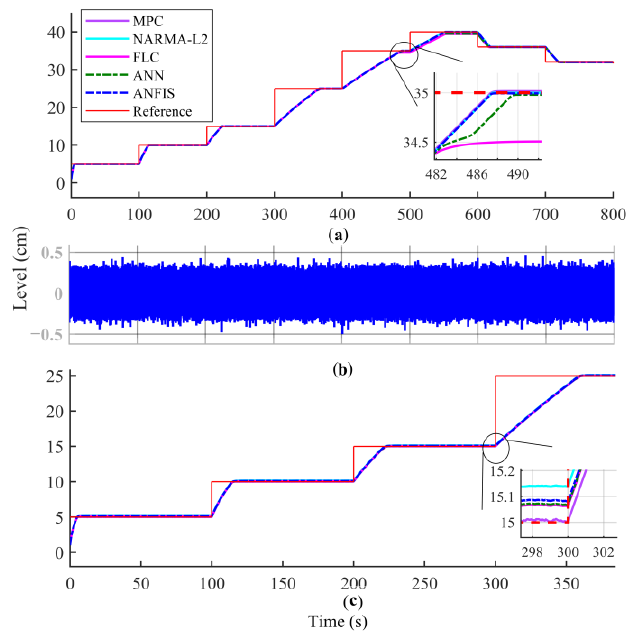
Figure 19. Controller performance in the face of parametric uncertainty and noise. ( a ) Control response to parametric uncertainty. ( b ) Noise signal used. ( c ) Effects of noise on process control.